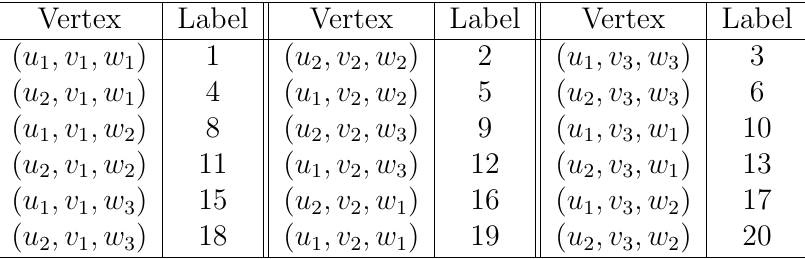
Table 3: A radio labeling of K